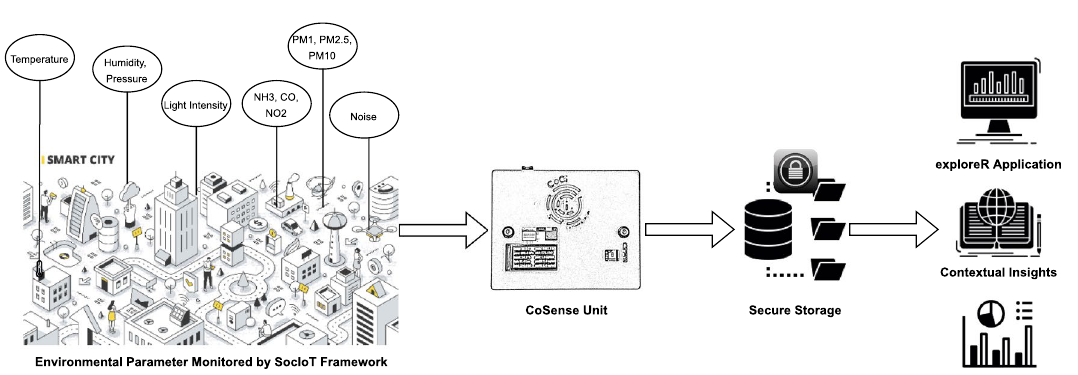
Figure 2. Overview of the proposed